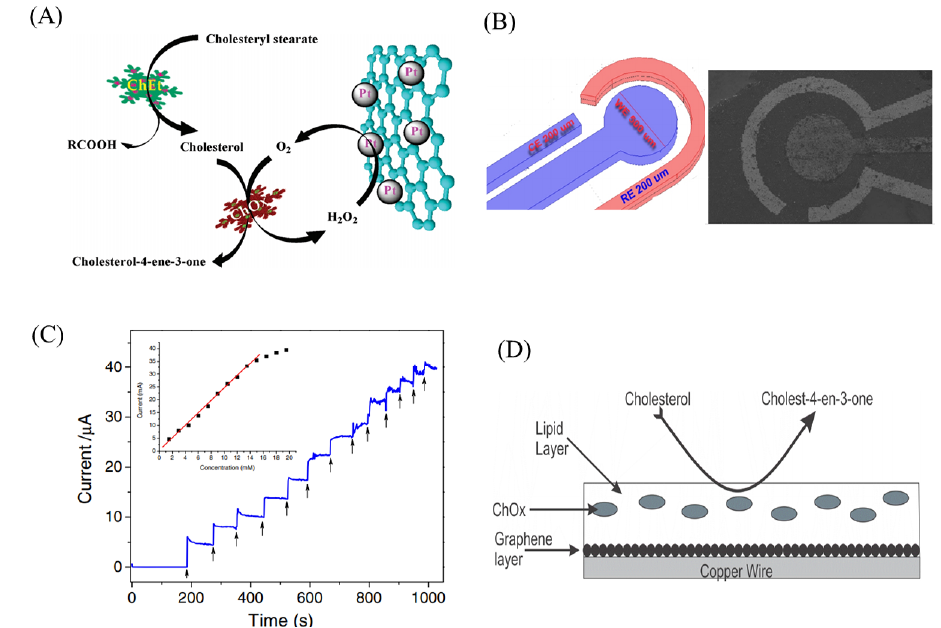
Figure 5. ( A ) Schematic of the the GNS-nPt-Based Biosensor for cholesterol detection. ( B ) A schematic and SEM image of the graphene electrode modified with Fe 3 O 4 -doped polyaniline film. ( C ) Amperometric responses obtained for different added cholesterol concentrations (inset: the calibration curve of the cholesterol sensor). ( D ) Schematic of the potentiometric sensor design. Figures reproduced with permission (cid:13) (cid:13) (cid:13) from: ( A ) [86], ACS c ; ( B , C ) [87], IOP Publishing c ; and ( D ) [88], Gruyter GmbH c